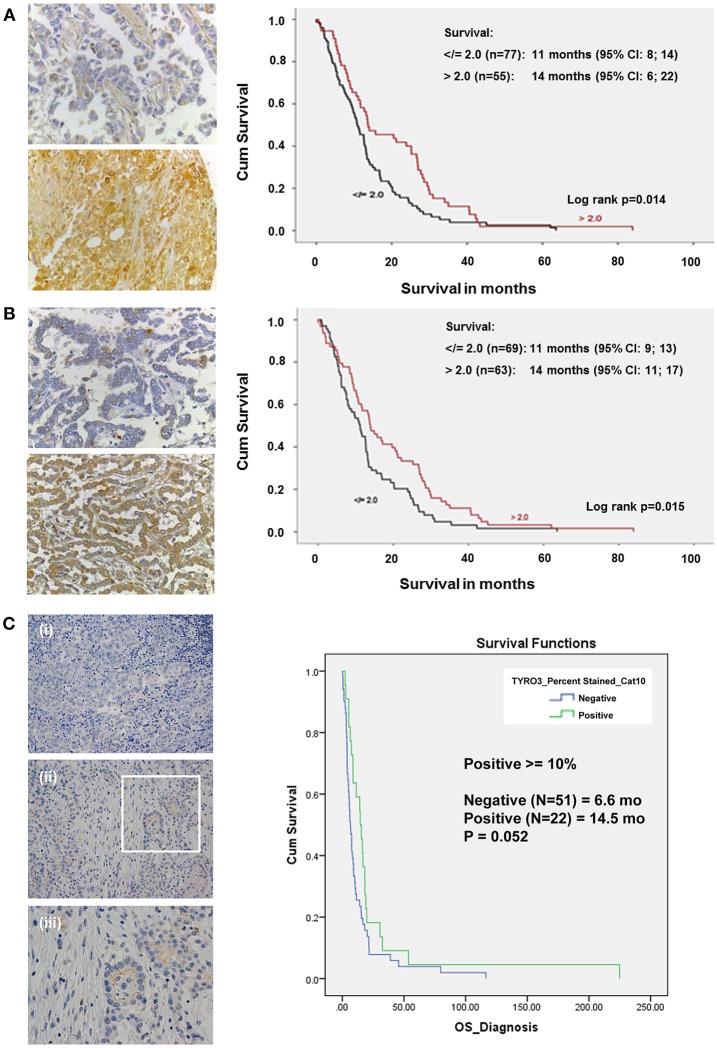
In a cohort of MPM patient samples, elevated levels of MST1R (RON) and MST1 are associated with increased survival. (A) Immunohistochemical staining of an MPM TMA for MST1R (Santa Cruz Biotechnology, sc-322, RRID: AB_677390), at (40x) magnification for both focal positive and strongly positive cores. Following scoring by two pathologists, and dichotomized closest to the median into low and high using >2, </=2 global scores, the results were analyzed using Cox regression for survival on (n = 132) patients for which clinical data was available. High expression of RON was found to be an independent prognostic factor correlating with an overall increased survival (14 vs. 11 months, p = 0.014). (B) Immunohistochemical staining of an MPM TMA for MST1 (Santa Cruz Biotechnology, sc-6088, RRID: AB_2235679). At (40x) magnification, both focal positive and strongly positive cores were observed. Following scoring by a pathologist and dichotomized closest to the median into low and high using >2, </=2 global scores, the results were analyzed using Cox regression for survival on (n = 132) patients for which clinical data was available. High expression of MST1 was found to be an independent prognostic factor correlating with an overall increased survival (14 vs. 11 months p = 0.015). (C) Immunohistochemical staining of an MPM TMA for Tyro3 (Abcam ab79778, RRID: AB_10673822) in a patient tumor sample. (i) 20x negative control; (ii) 20x, and (iii) 40x magnification of the inset highlighted in (ii). At (20x and 40x) magnification, both cytoplasmic/membranous staining is observed. When scored and categorized into positive and negative with positive > = 10%, Kaplan-Meier Analyses (with OS from time of diagnosis) was not significant (14.5 vs. 6.6 months p = 0.052).